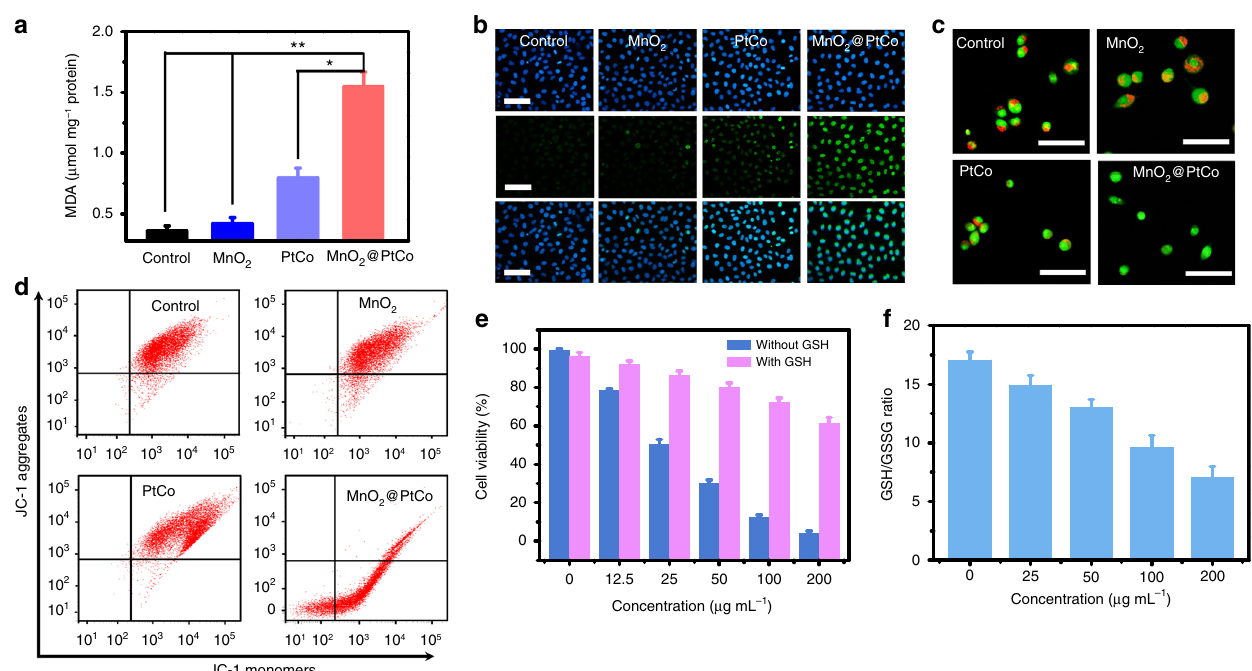
Fig. 6 Cell death mechanism caused by MnO 2 @PtCo nano fl owers in hypoxic environment. a Changes of MDA content in 4T1 cells following treatment with different formulations. Asterisks indicate signi fi cantly differences ( * P < 0.01, ** P < 0.005, *** P < 0.001), analyzed by unpaired Student ’ s two-sided t test. b γ -H fl uorescence staining of 4T1 cells incubated with various nanomaterials. The nucleus was stained with DAPI (blue) and 2 AX foci immuno γ -H μ m. c Fluorescence images of AO staining to evaluate 2 AX (green) was visualized by the FITC-labeled secondary antibody. Scale bars are 100 lysosomal integrity of 4T1 cells with different treatments. Scale bars are 200 μ m. d JC-1 analysis of 4T1 cells as a measure of mitochondrial depolarization after treatment with different formulation. e The cell viability incubated with different concentrations of MnO 2 @PtCo nano fl owers with GSH or without GSH added. f GSH/GSSH ratios of 4T1 cells treated with different concentrations of MnO 2 @PtCo nano fl owers. Data were presented as mean ± s.d. ( n = 5)